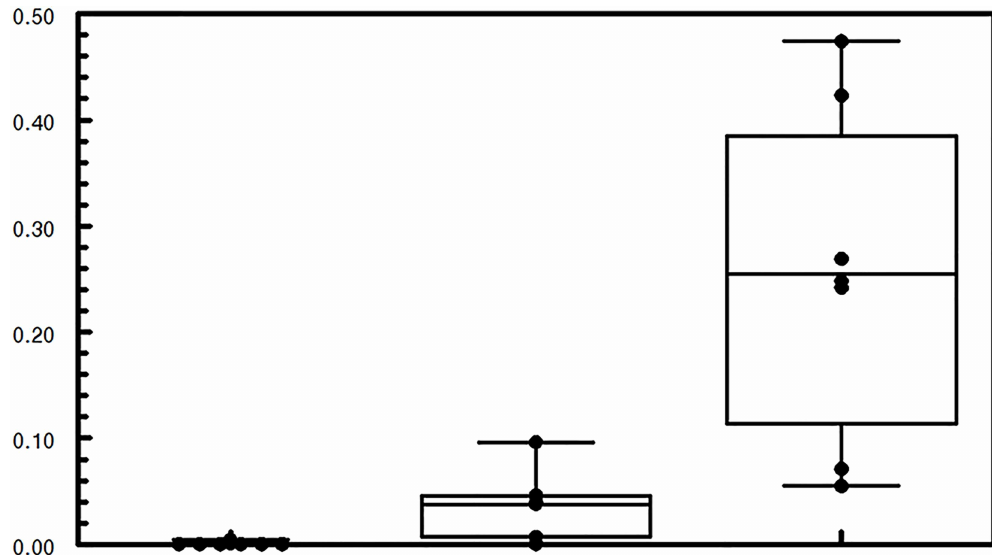
Fig 4. Dithiocarbamate (DTC) concentration in 21 randomly selected plasma samples. Treatments are labeledas placebo(no sulforaphane), 25 μ M, and 150 μ M of sulforaphane.